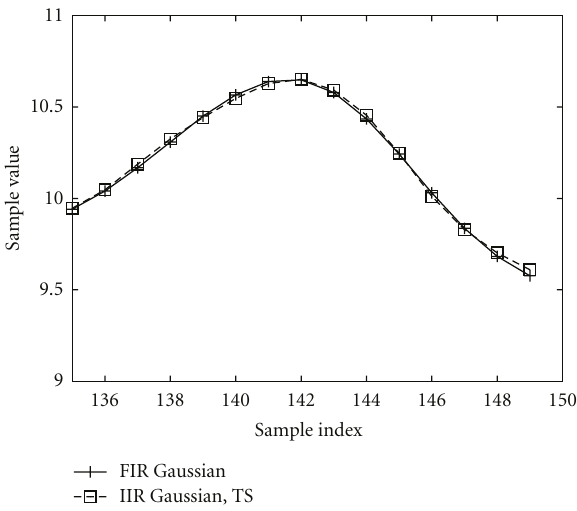
Figure 3: The forward-backward transition initiates correctly when compared to an FIR implementation. Compare it with Figure 1.